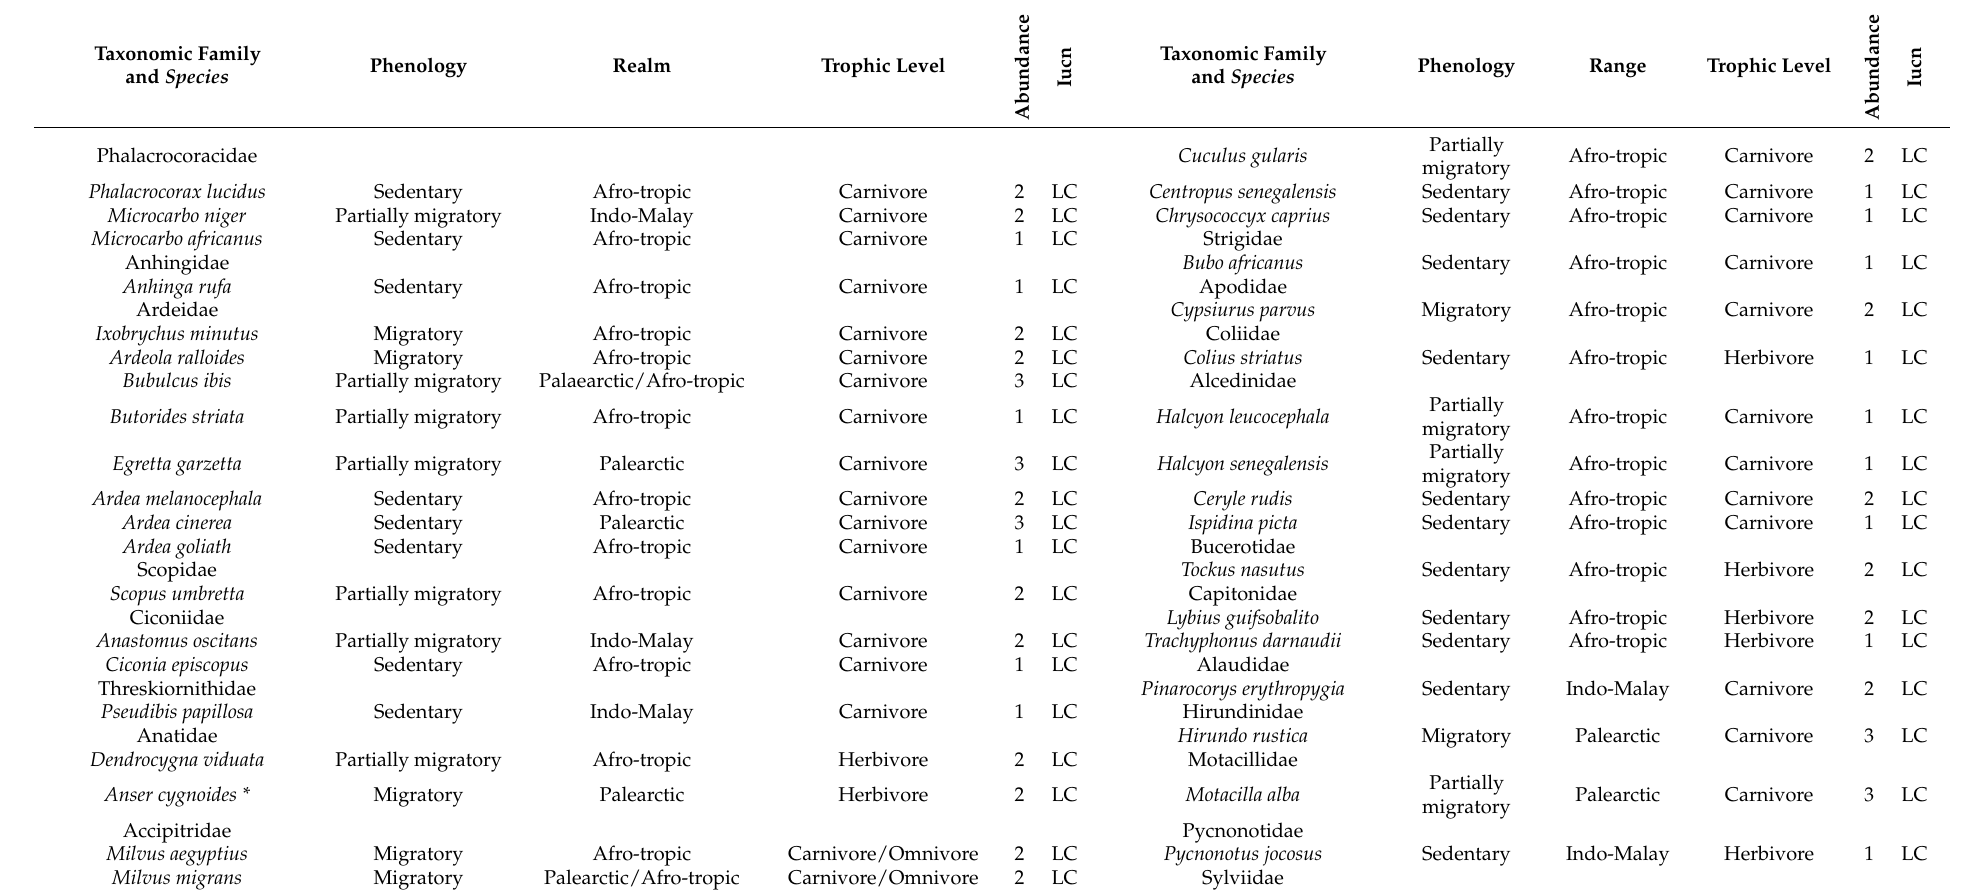
Table A1. Check-list of the sampled species (in systematic order) with the regional phenology, realm of distribution (chorology), trophic level, classes of local abundance (+: rare; 1: uncommon; 2: frequent; 3: abundant), and level of conservation concern (IUCN threat category; source: iucnredlist.org: LC: Least Concern; EN: endangered; CR: Critically endangered). *: Introduced